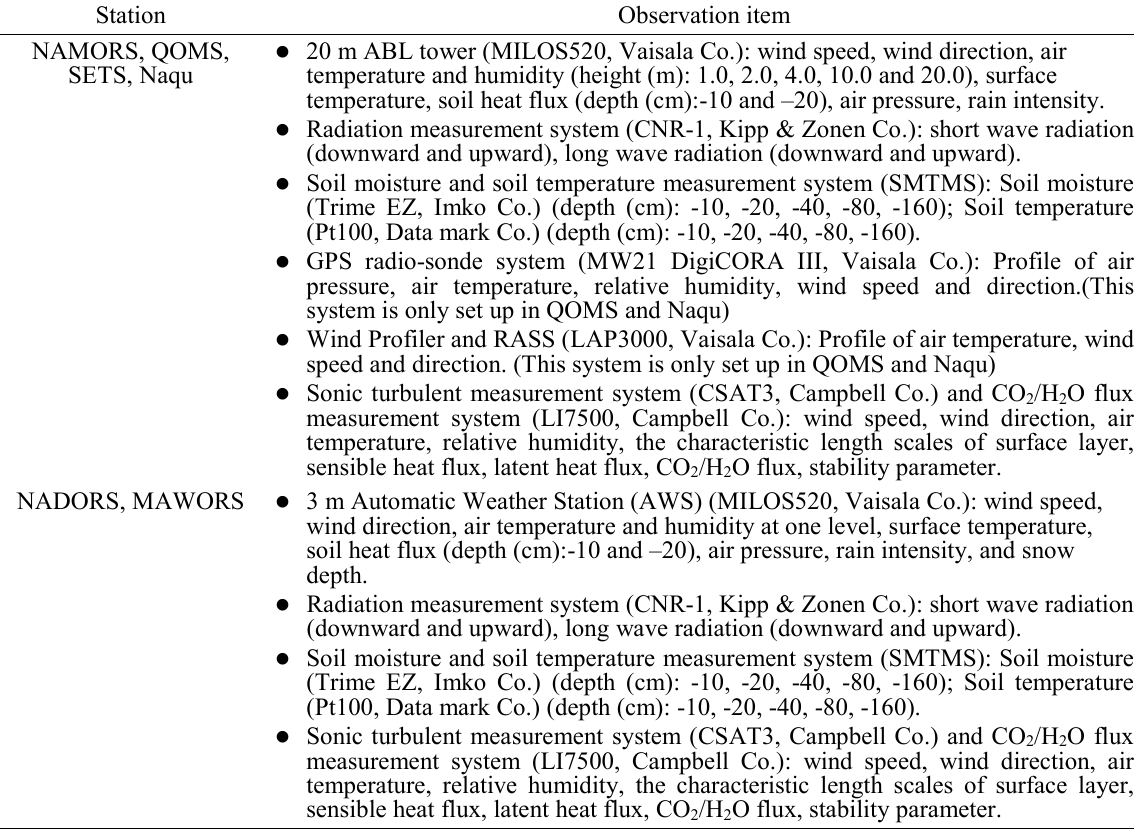
Table 1 The instruments and parameters measured in the six constructed stations of ITP/CAS in the TPE (NAMORS, QOMS, SETS, NADORS, MAWORS and Naqu).